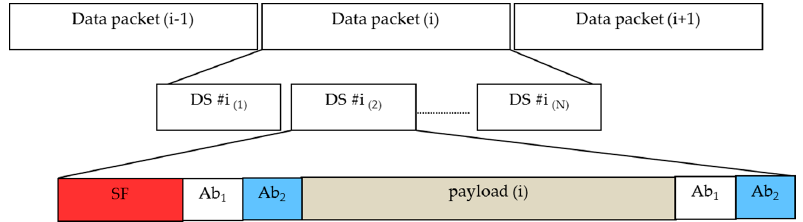
Figure 10. Proposed data frame structure #2—a solution for high packet rate transmission or frame drop error correction.